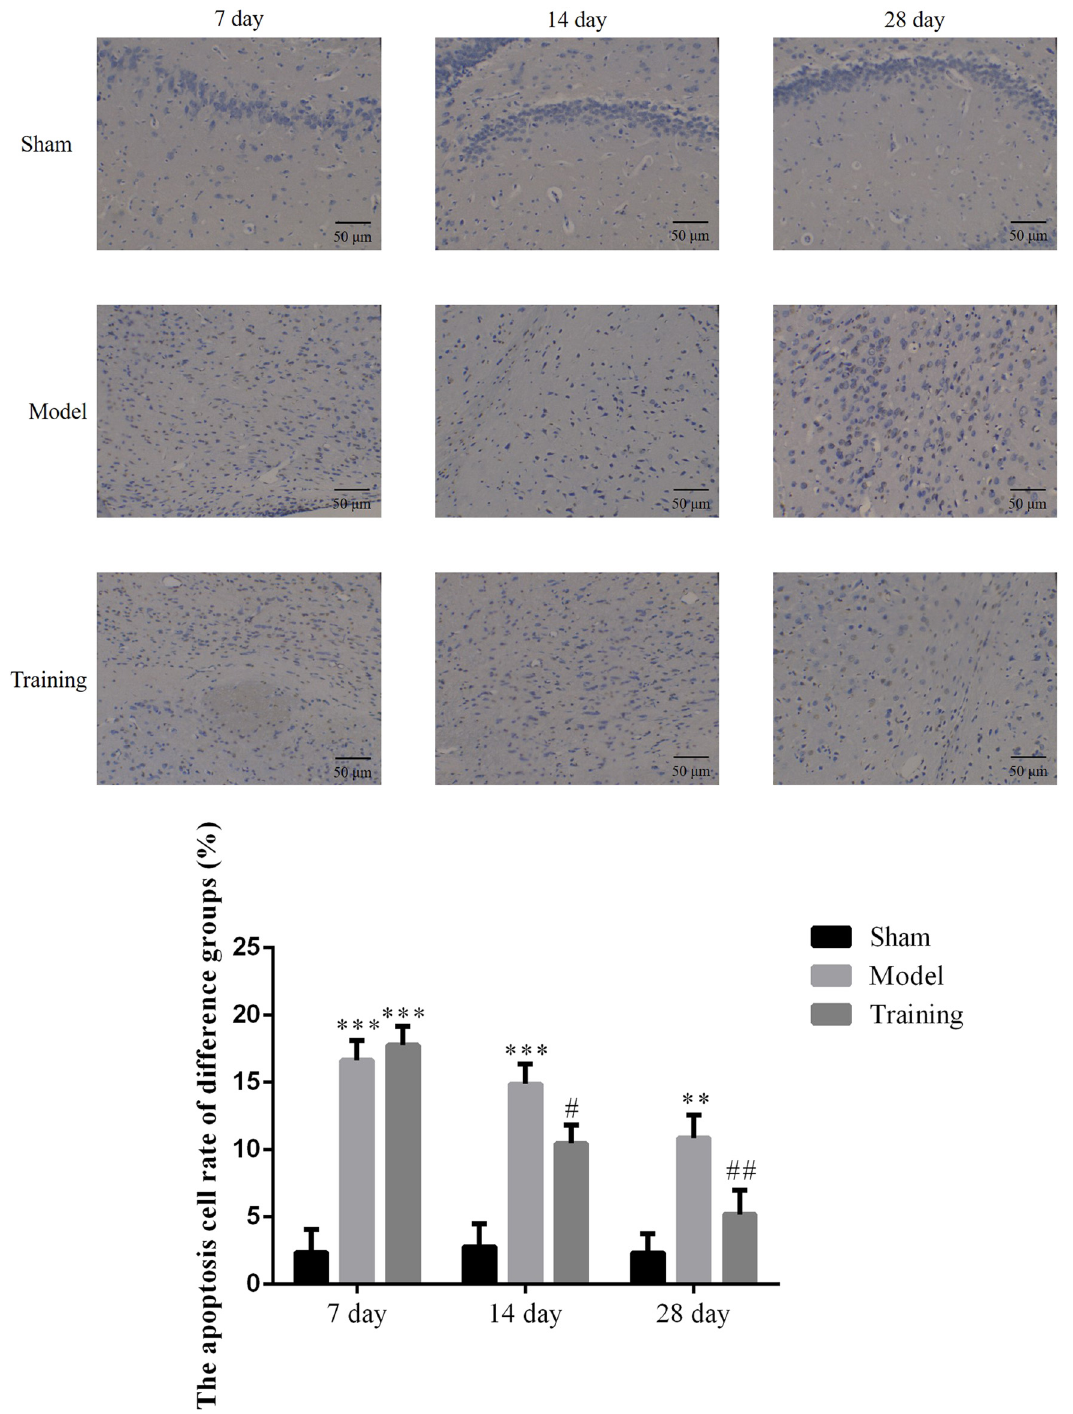
Figure 1: The apoptosis cell rate of di ff erent groups by TUNEL assay (× 200 ) . Sham: Sham group; Model: nerve injuries in CCI rat model; Training: nerve injuries in CCI model rats that were treated with rehabilitation training exercises; ** P < 0.01, *** P < 0.001 compared with the Sham group; # P < 0.05, ## P < 0.01 compared with the Model